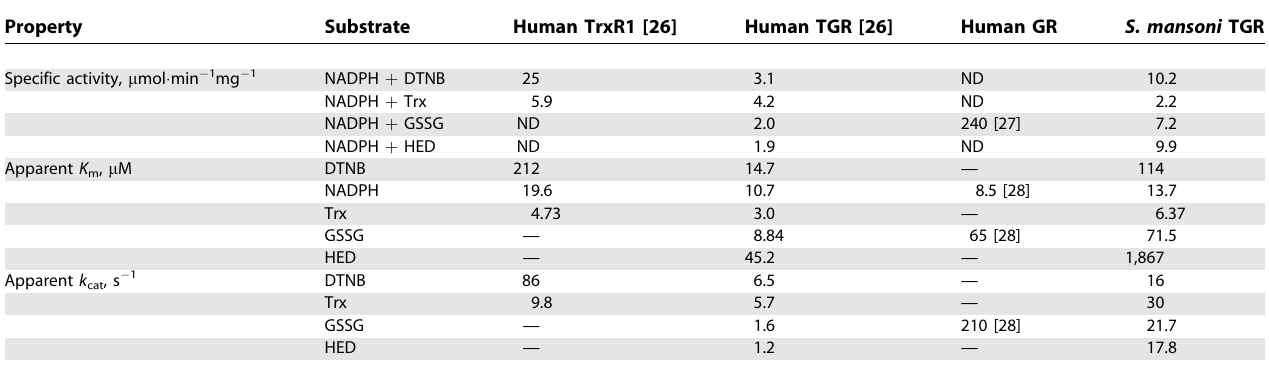
Table 2. Comparison of the Kinetic Properties of Human TrxR1, TGR, and GR to Recombinant S. mansoni TGR Property Substrate Human TrxR1